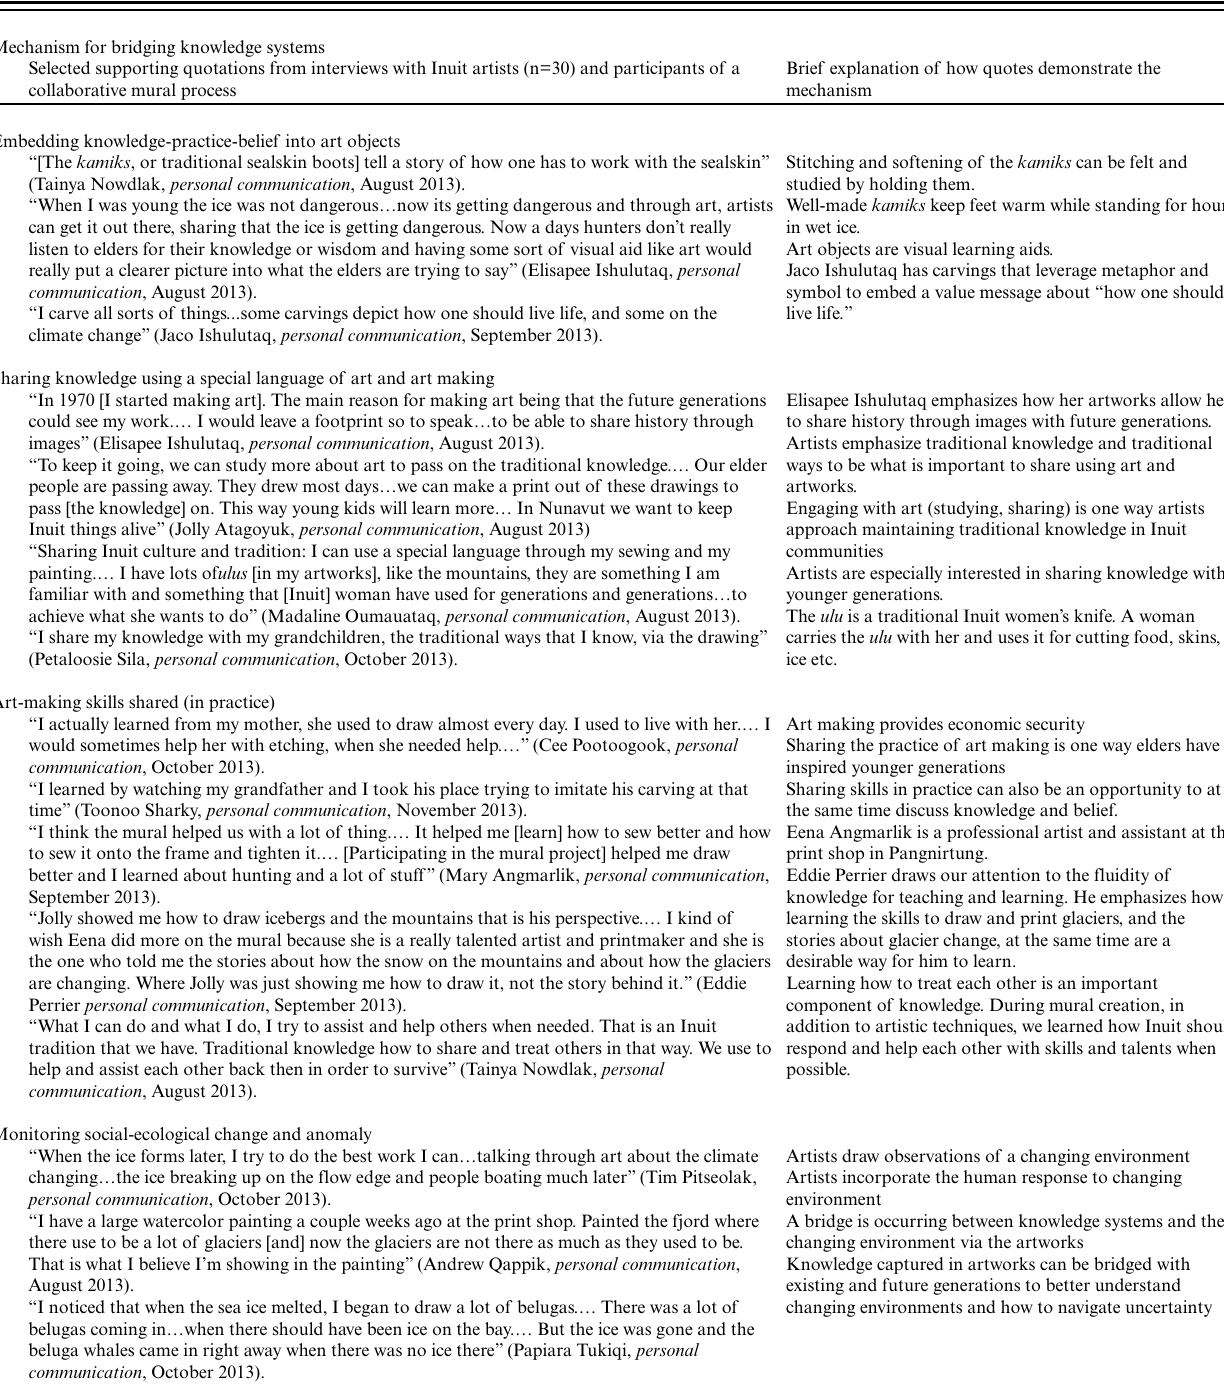
Table 1 . Summary of mechanisms through which art and artistic processes support knowledge system bridging. Selected supporting quotes are provided. We describe when necessary context and synthesize the connection between the quotes and the mechanism underlying knowledge system